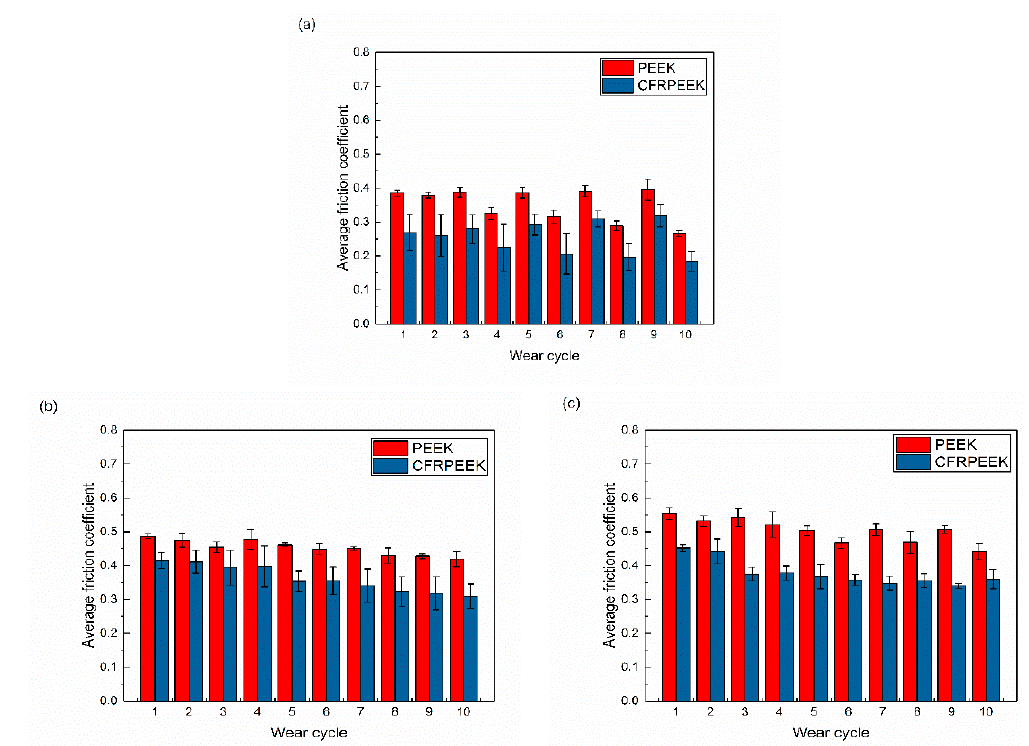
Figure 4. The average friction coefficients of PEEK and CFRPEEK in the constant load nanoscratch tests: ( a ) 10 mN, ( b ) 30 mN, and ( c ) 60 mN.